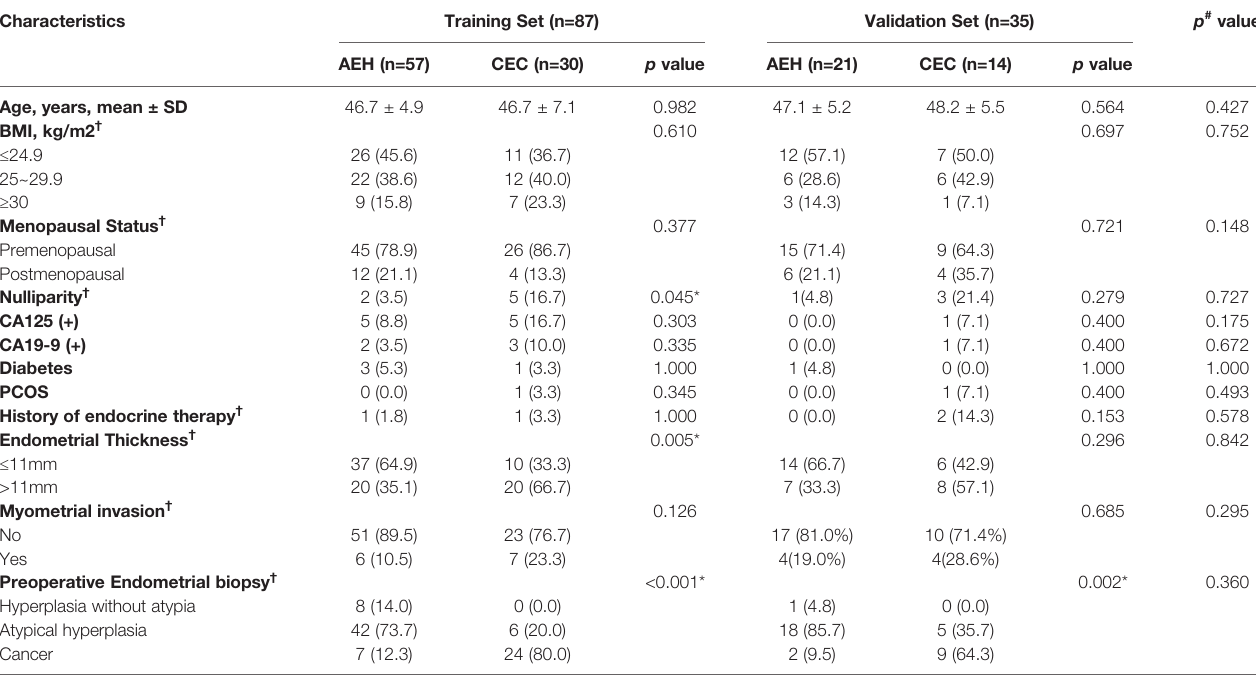
TABLE 2 | Baseline Characteristics of Patients in the Training and Validation sets.